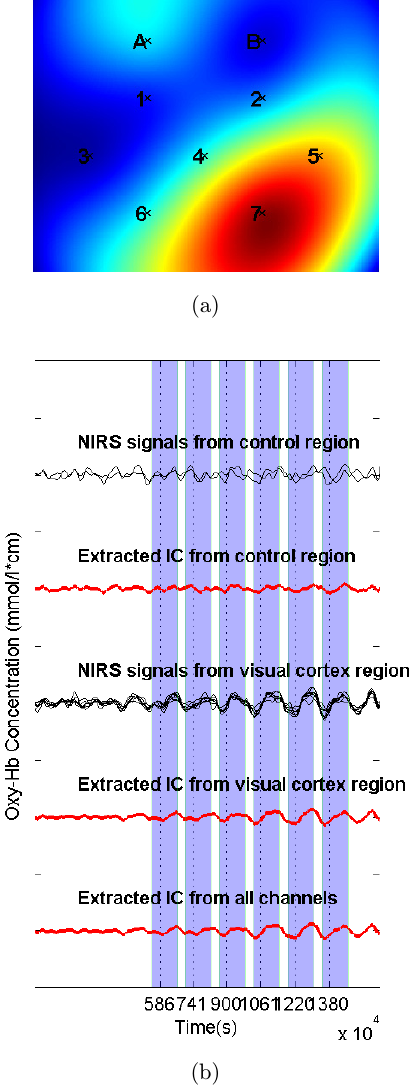
Fig. 5. Evoked Oxy-Hb responses with 0 Hz °ickering stimu- lus. (a) Spatial map of ICs extracted from all channels and (b) Extracted ICs and original signals of visual cortex region vs control region.